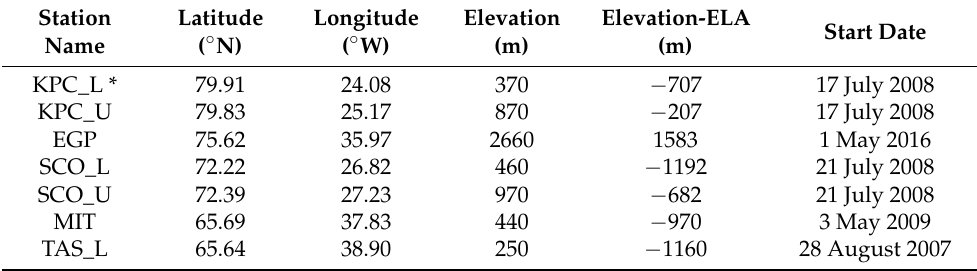
Table 1. Geographical characteristics of the meteorological stations used in this study.